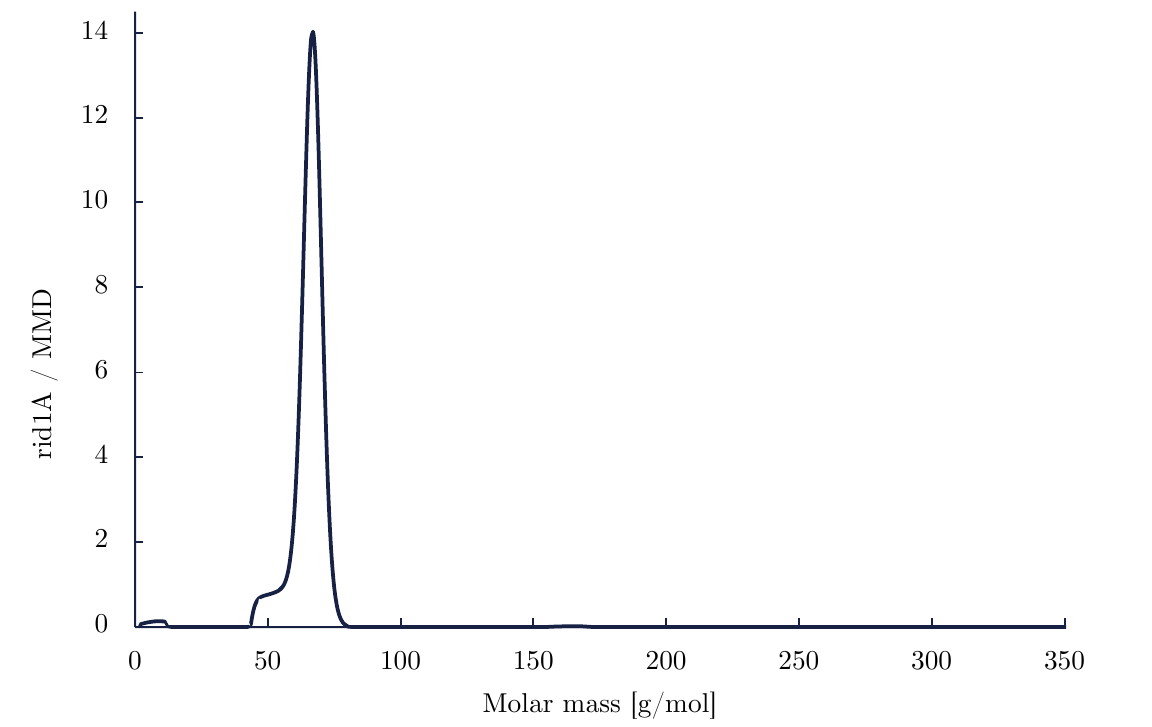
Figure A4. GPC chromatogram obtained from the neutralized samples, indicated too much dilution.